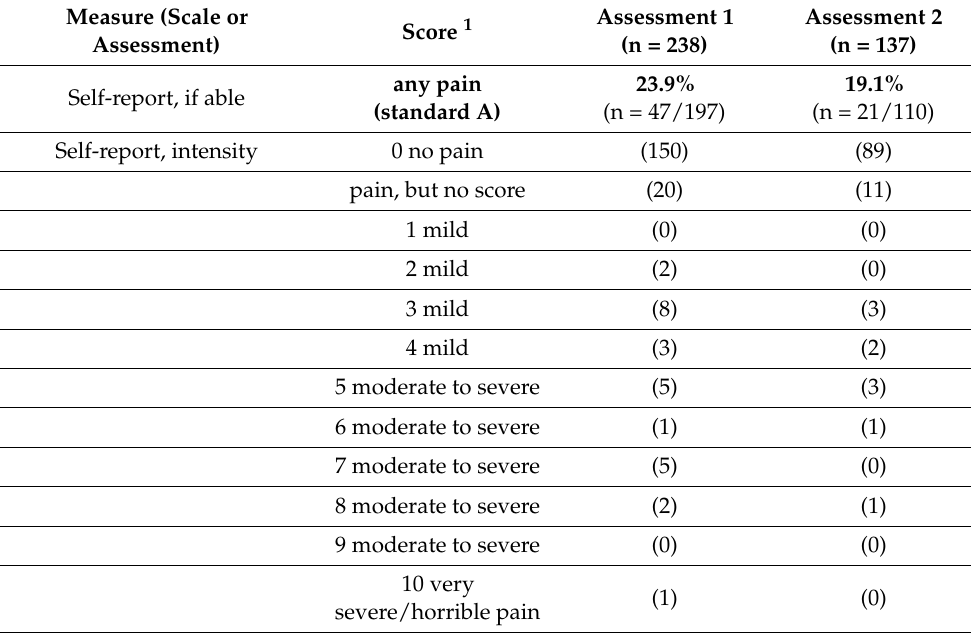
Table 4. Pain standard